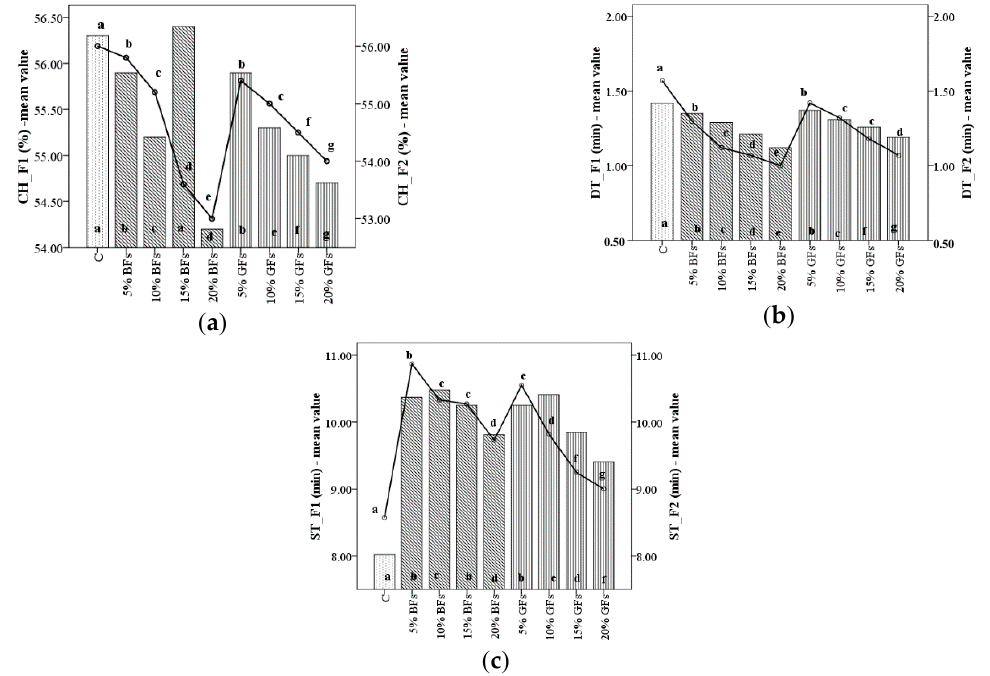
Figure 1. Mixolab parameters during mixing of WF (C) and flaxseed–wheat composite flours formulated by adding different levels (5,10,15 and 20%) of brown flaxseed (BFs) and golden flaxseed flour (GFs), respectively, in two types of flour—F1 and F2: ( a ) CH: water absorption; ( b ) DT: development time; and ( c ) ST: stability. Different letters indicate significant differences ( p < 0.05) between samples.